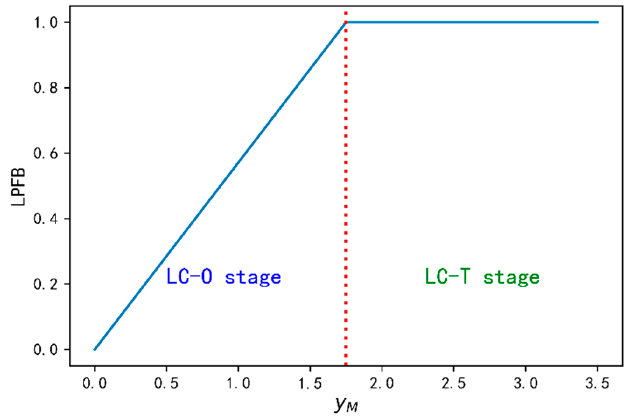
Figure 5. The trajectory curve of linear piecewise function 𝐿𝑃𝐹𝐵 .